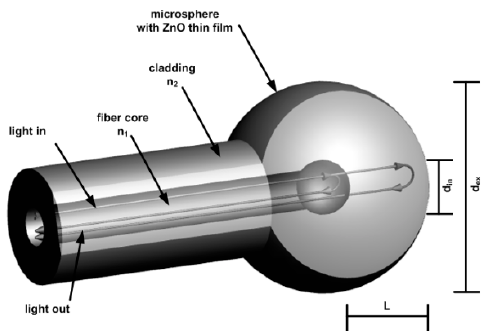
Figure 1. Schematic model of the microsphere with 200 nm ZnO thin film deposited on the surface, where: d in —internal diameter of the sphere, d ex —external diameter of the sphere, L —cavity length, n i —refractive index.